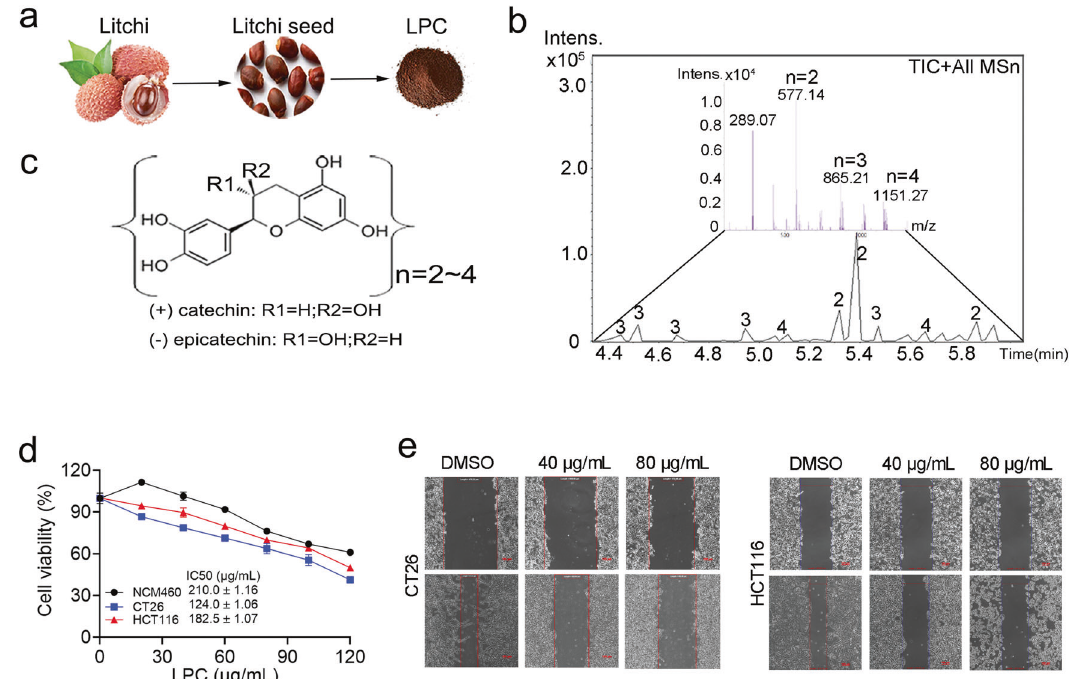
Fig. 1 LPC inhibits the proliferation and migration of CT26 colon cancer cells. a Source of LPC. b Identi fi cation of LPC by UPLC-Q/TOF-MS. c Inferred composition of LPC. d Cell viability was measured by MTT assay ( n = 4). e Cell migration was measured by wound healing assay. Data were presented as means ±